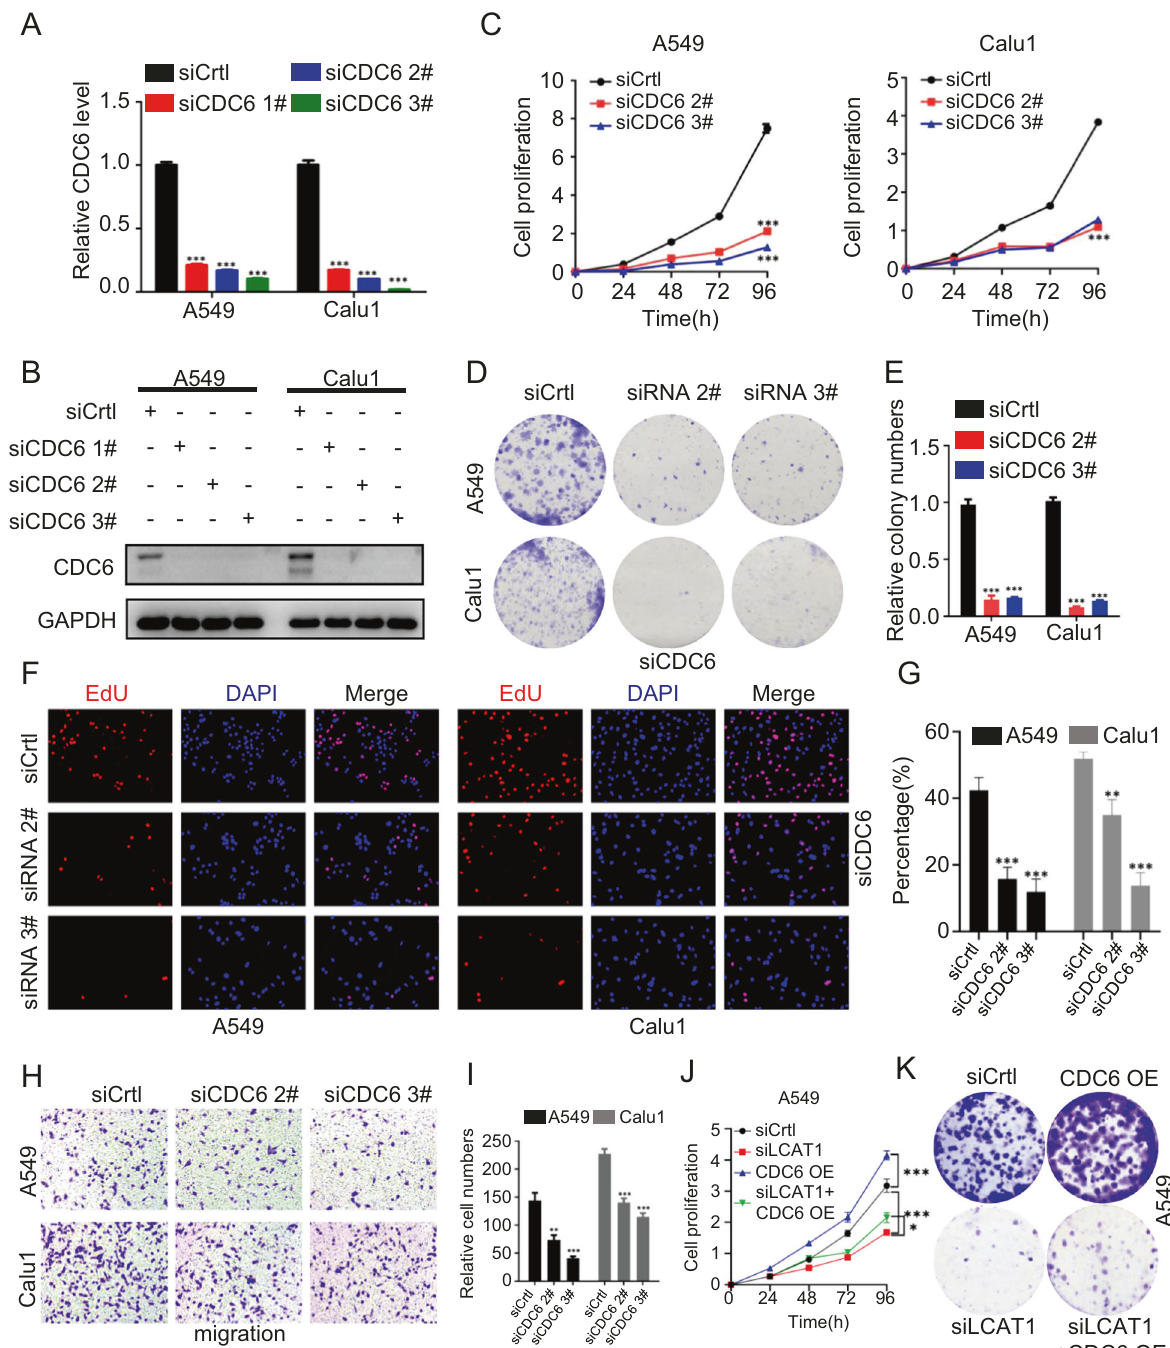
Fig. 5 CDC6 knockdown inhibits lung cancer cell proliferation, colony formation, and migration. A , B qPCR and western blot were taken to measure the CDC6 expression in A549 and Calu1 cells transfected with CDC6 siRNAs and negative control. C – G CCK-8 ( C ), colony formation ( D , E ), and EdU staining ( F , G ) assays were performed to evaluate the impacts of CDC6 depletion on lung cancer cell viability. H , I Transwell assays were conducted to determine the migration ability of CDC6 silenced and control cells. J , K Growth curve and colony formation assays were performed in A549 cells co-transfected with siLCAT1 and CDC6 overexpress vector. * P < 0.05, ** P < 0.01, *** P < 0.001.